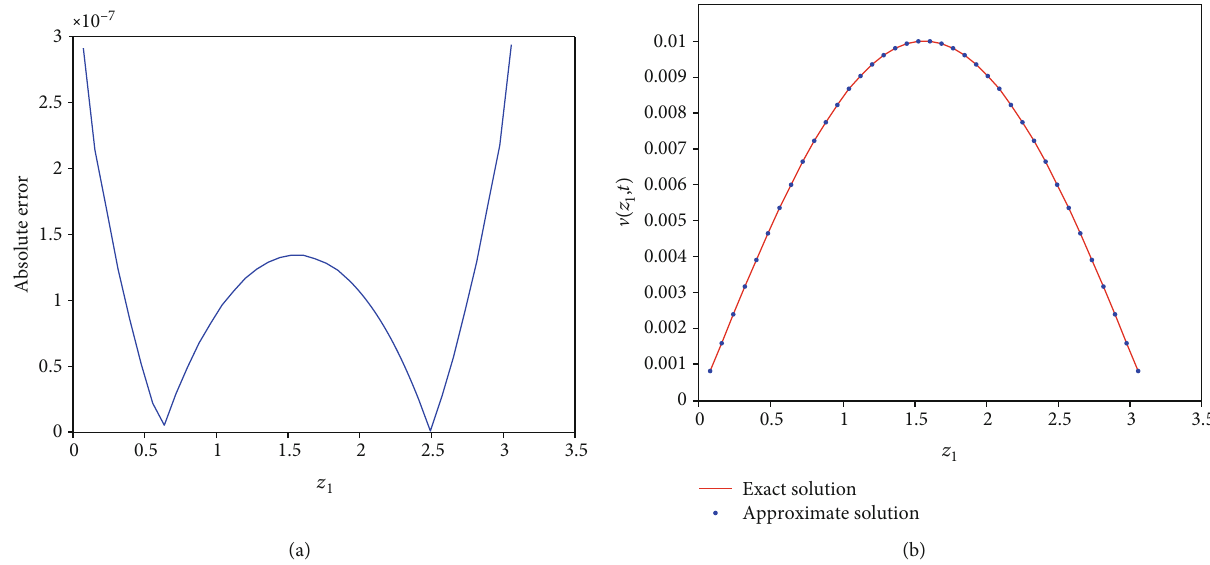
Figure 6: (a) E and (b) exact and approximate solution for α = 0 : 50 for the Problem 5. abs